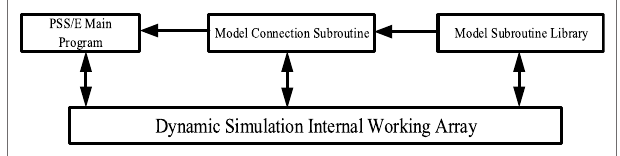
FIGURE 1 | Relationships among different modules associated with